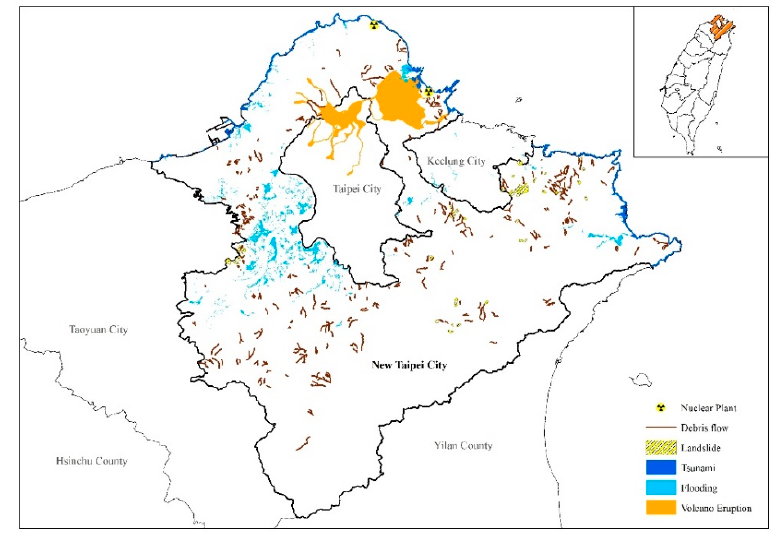
Figure 1. Study Area and Disaster Potential.